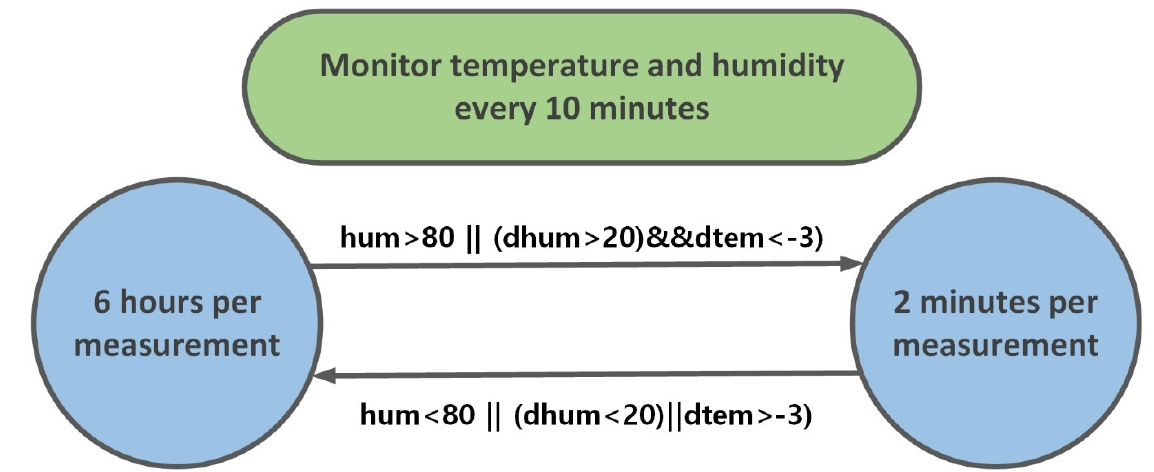
Figure 4. Block diagram of the event-driven algorithm.